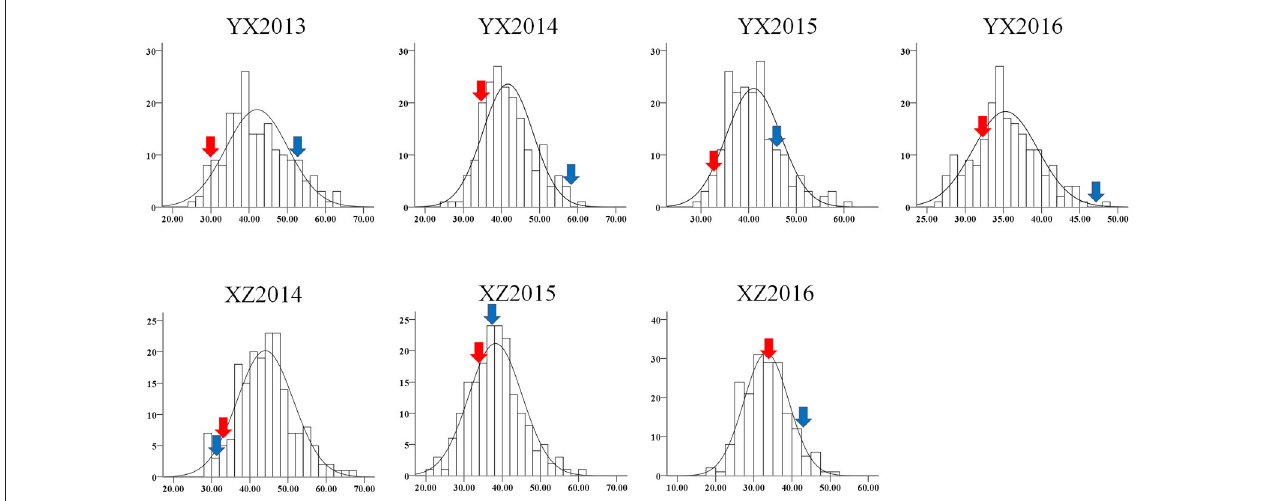
FIGURE 1 | Phenotype distribution of plant height in two RIL populations. The y-axis represents frequency; the x-axis represents value of plant height. YX “Yuanza9102 × Xuzhou 68-4” RIL population, XZ “Xuhua 13 × Zhonghua 6” RIL population. Red and blue arrows denote female and male parents, respectively.